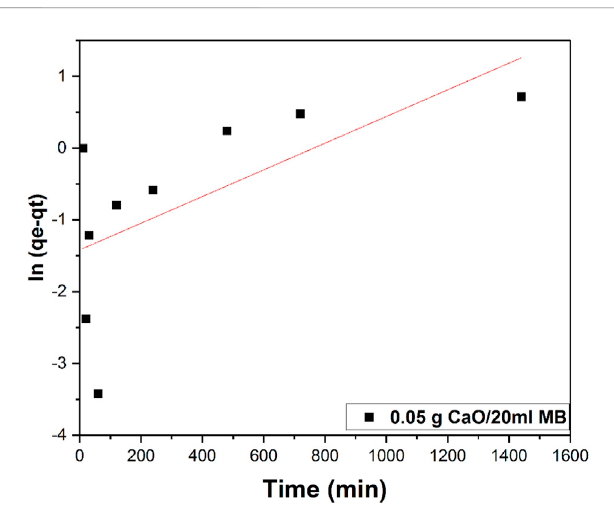
FIGURE 14 Langmuir isotherm studies for 0.05 g CaO adsorbent dose per 20 ml MB (10 mg/L).